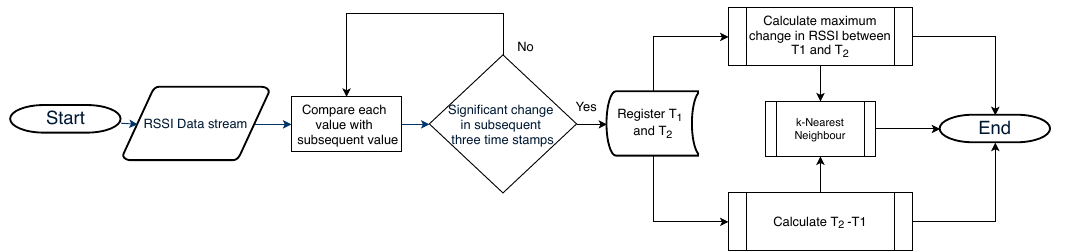
Figure 7 below represents the overall flow of the algorithm: